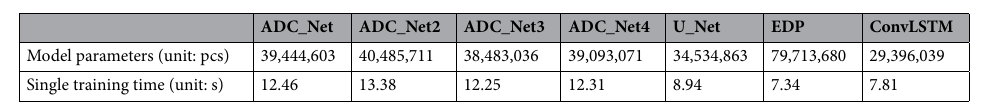
Table 4. Performance